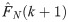
Forecasts, F^N(k+1) obtained from optimal utilization of reference forces, F→N*(k) and F→aN(k).The rectangular box shows the trend patterns of the forecast bounded between the trends of the reference forces.